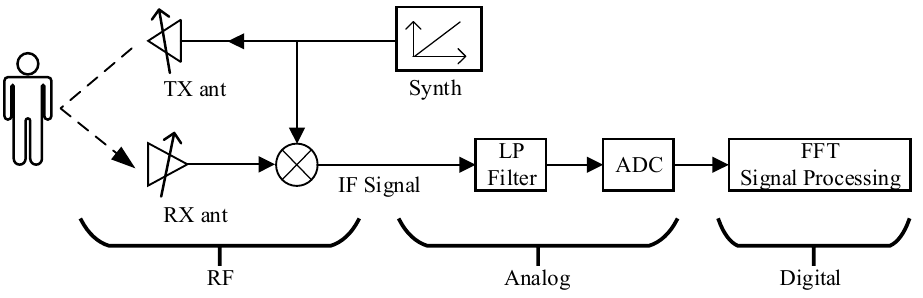
Figure 1. A simplified block diagram of the FMCW radar system [5–9].